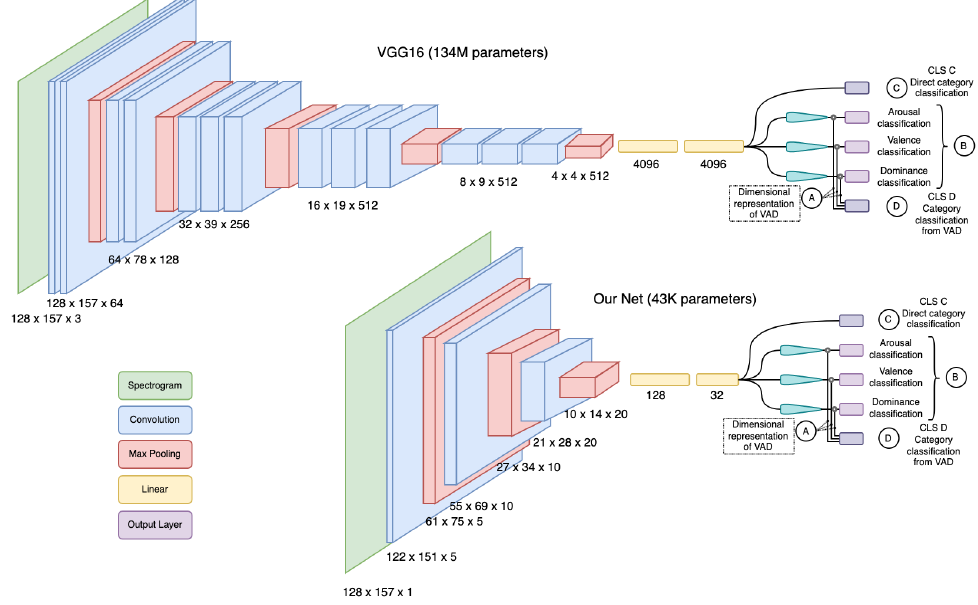
Figure 1. Representation of the structure of the VGG16 [9] network and our proposal. In both cases, the convolutions (blue boxes) and max-poolings (red boxes) help to extract a set of appropriate features, while the linear ones are in charge of performing the class discrimination. Point A represents a dimensional prediction of the VAD model, while point B provides the discretisation of each of the dimensions. On the other hand, the categorical model is inferred directly in point C, and from the scalar VAD model predictions, in point